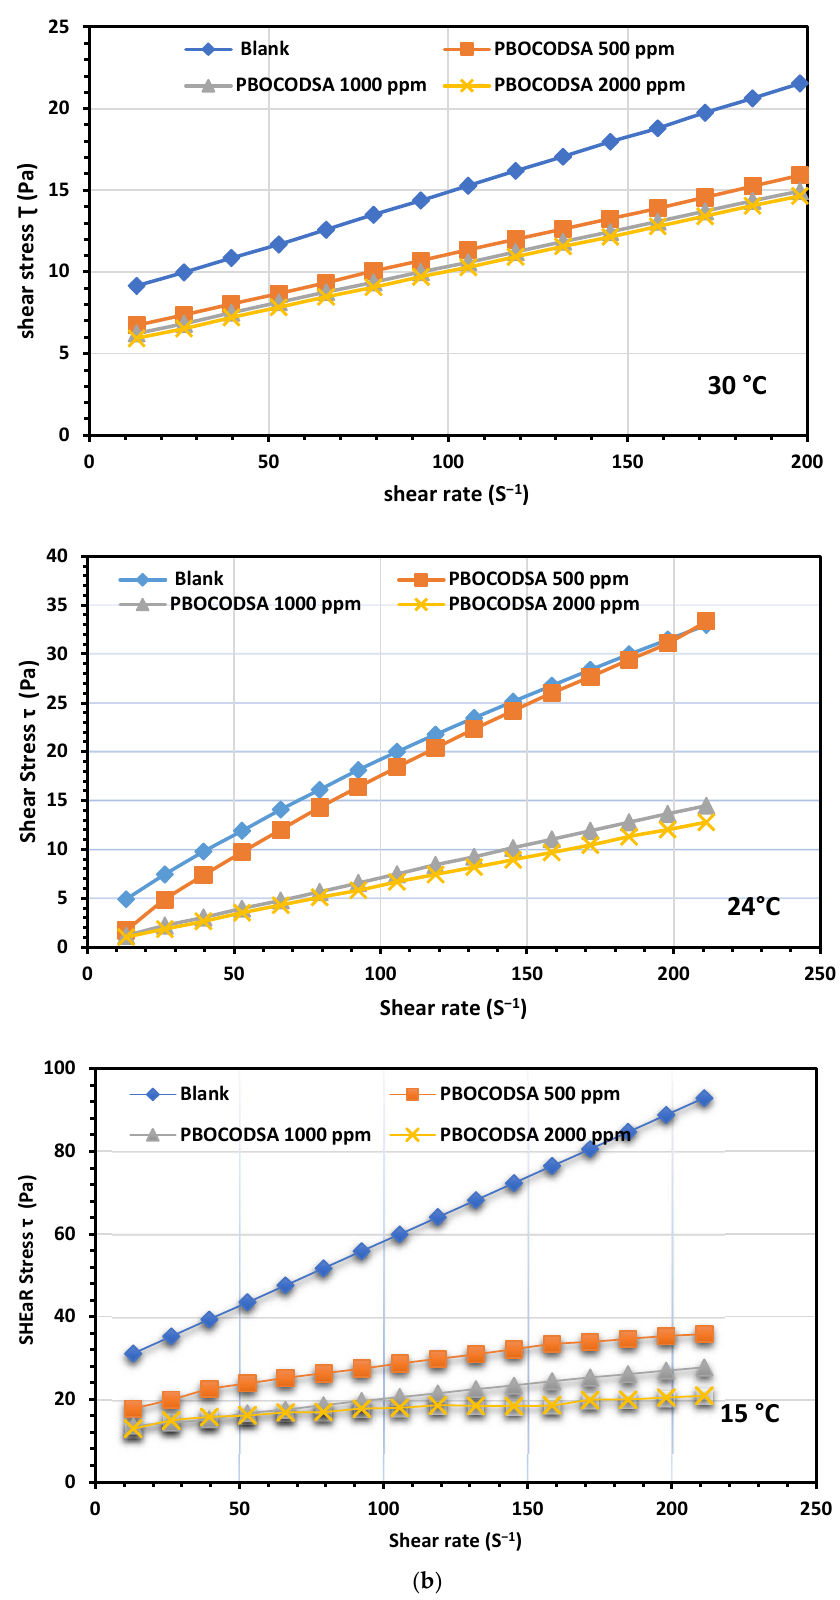
Figure 5. ( a ) Relation between shear rate and apparent viscosity for crude oil treated with PBOCODSA (500, 1000, and 2000ppm) at 15, 24, and 30 ◦ C. ( b ) Relation between shear rate and shear stress for crude oil treated with PBOCODSA (500, 1000, and 2000 ppm) at 15, 24, and 30 ◦